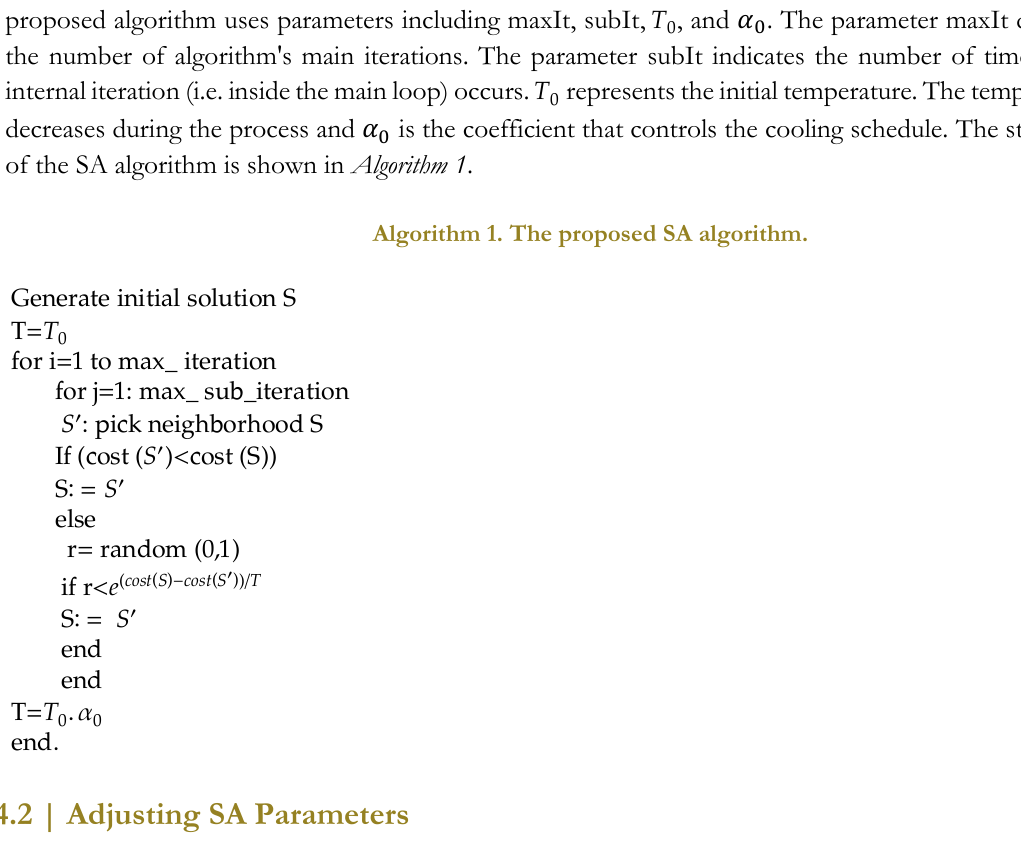
Fig. 1. Solution representation for the problem.